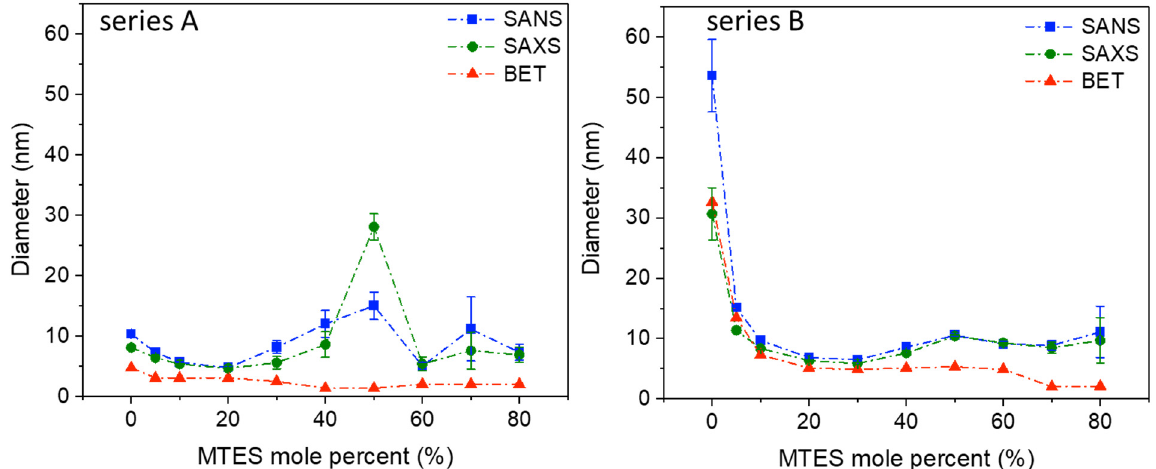
Figure 3. Diameter of pores from low-temperature nitrogen porosimetry DFT calculation (red), and sizes of the scattering objects—pores and particles together—from SAS (SANS—blue, SAXS—green) (series A and series B labels represent the pH = 2.0 and pH = 4.5).